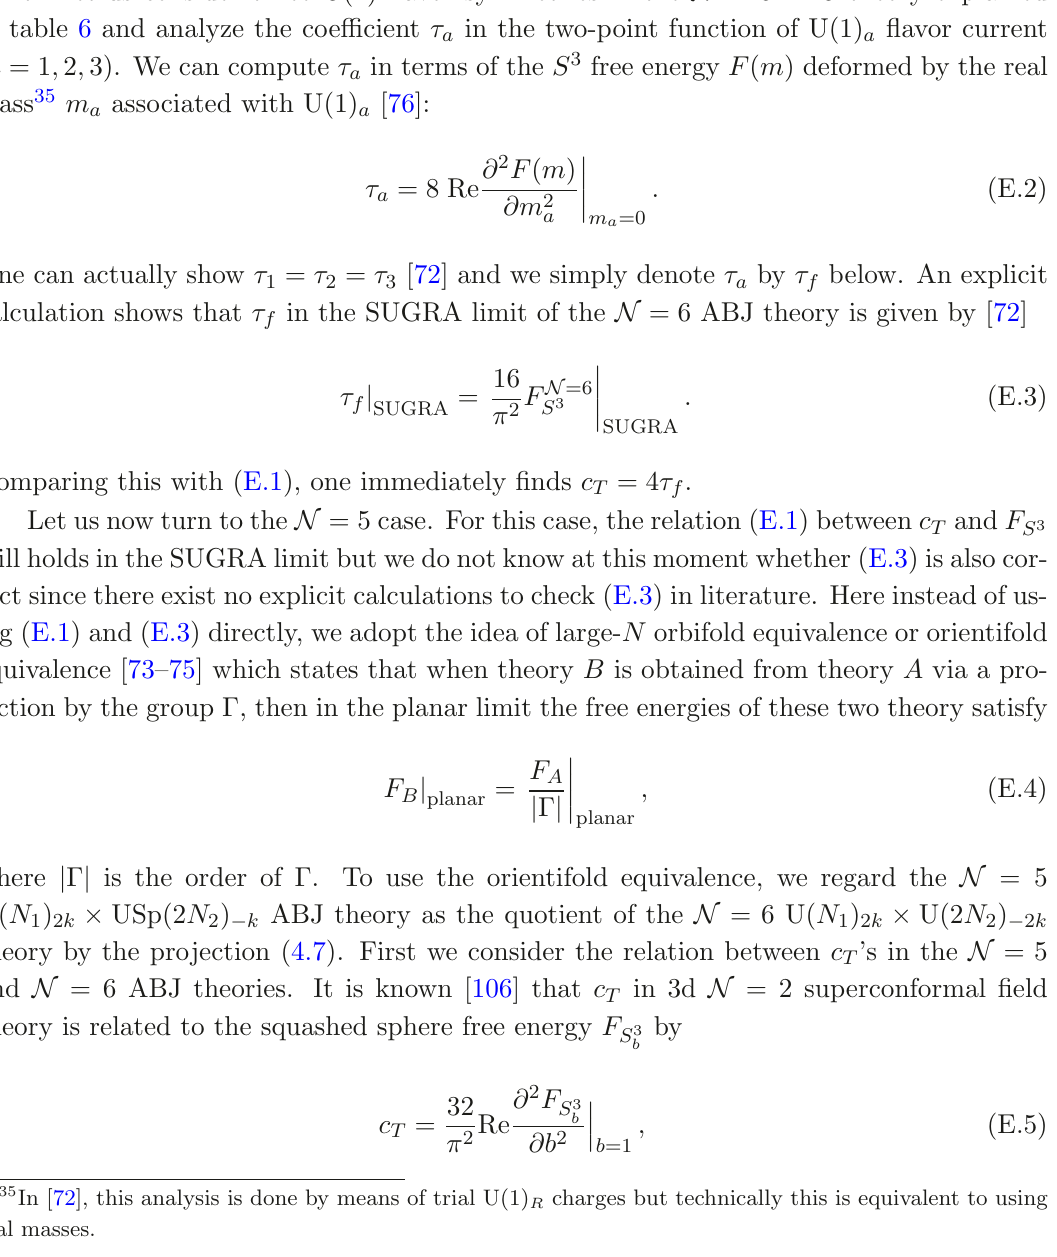
= 6 ABJ theory in 3d N in the = 6 ABJ theory in the classical S 3 N